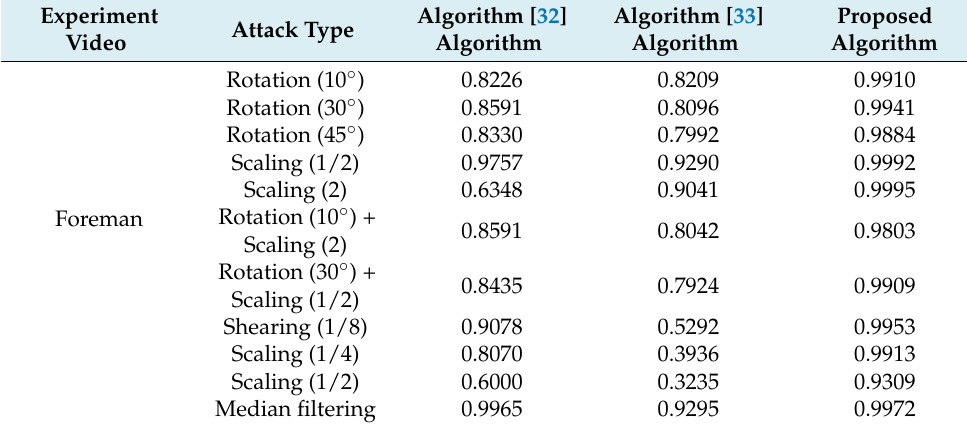
Table 4. Comparison of experimental results (NC value).